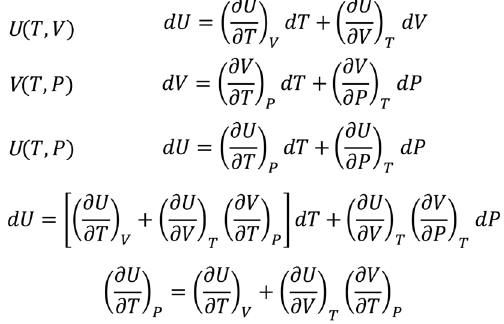
FIG. 4. The differentials submethod for deriving the analytical expression of the desired partial derivative.